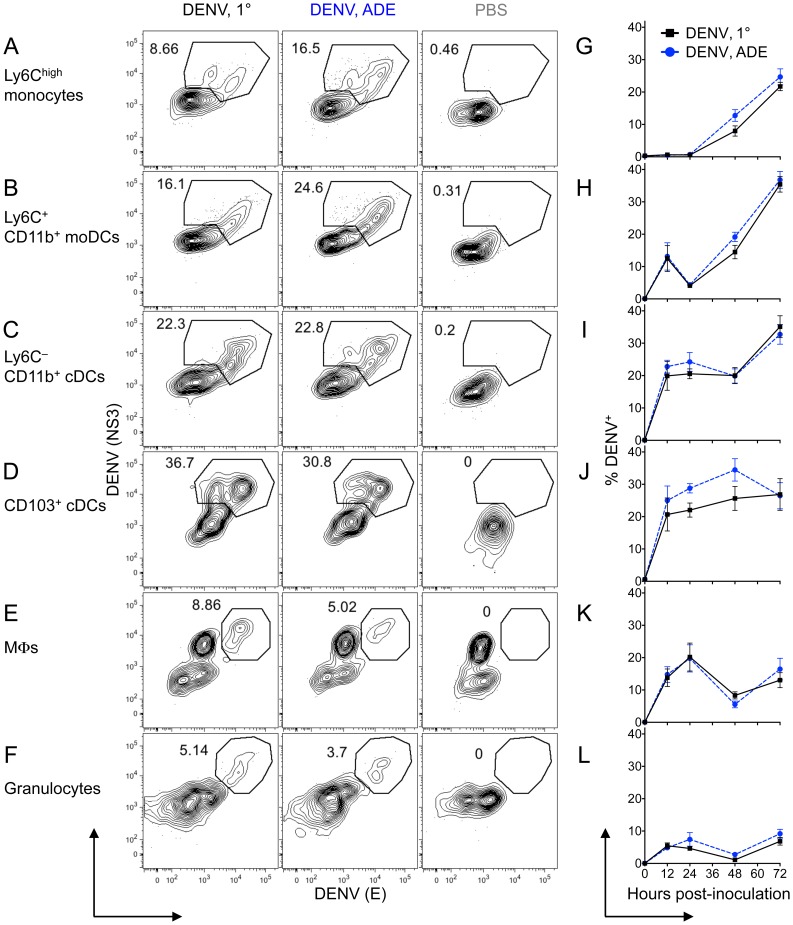
DENV infection of monocytes, DCs, and MΦs in the dermis.(A–F) Ifnar
–/– mice were inoculated i.d. with DENV2 during 1° or ADE infection or with PBS. Intracellular staining for DENV proteins NS3 and E is shown after 48 h. (G–L) Time-course of mean ±SEM of % NS3+ E+ DENV-infected cells for each population in the dermis under 1° (black square) or ADE (blue circle) infection conditions. Ly6Chigh monocytes (A and G), Ly6C+ CD11b+ moDCs (B and H), Ly6C– CD11b+ cDCs (C and I), CD103+ cDCs (D and J), MΦs (E and K), and granulocytes (F and L) were gated as in Fig. 4. Representative plots or pooled data are from 2–4 independent experiments (n = 6–12 per time-point and condition).